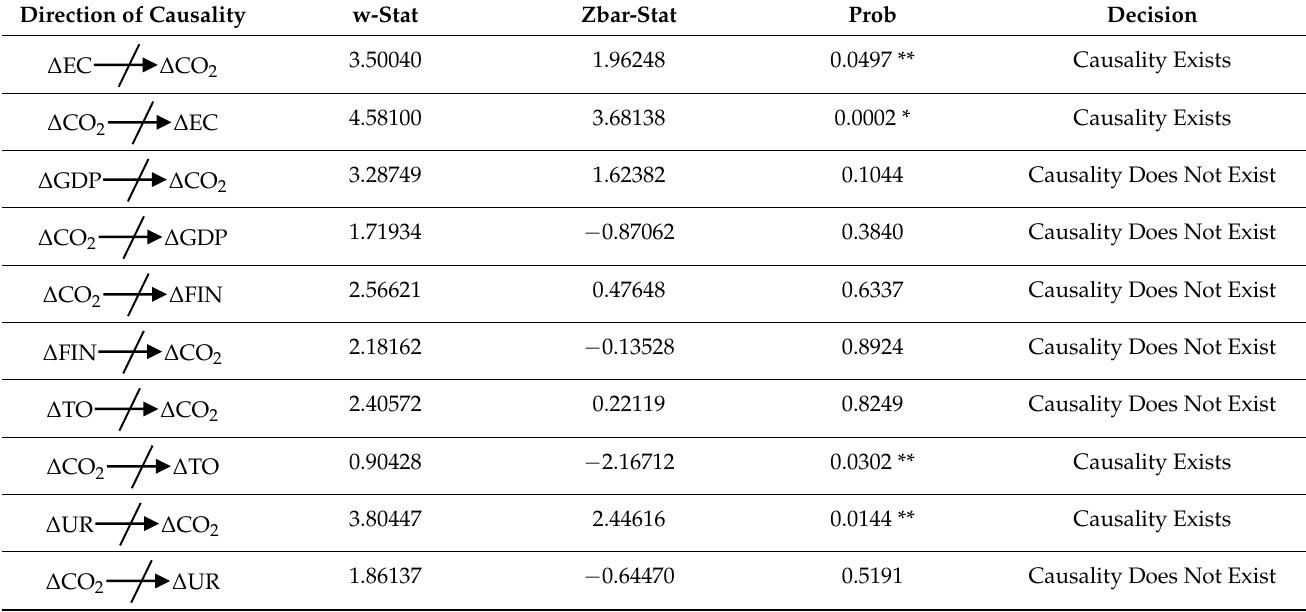
Table 10. Dumitrescu-Hurlin causality test.